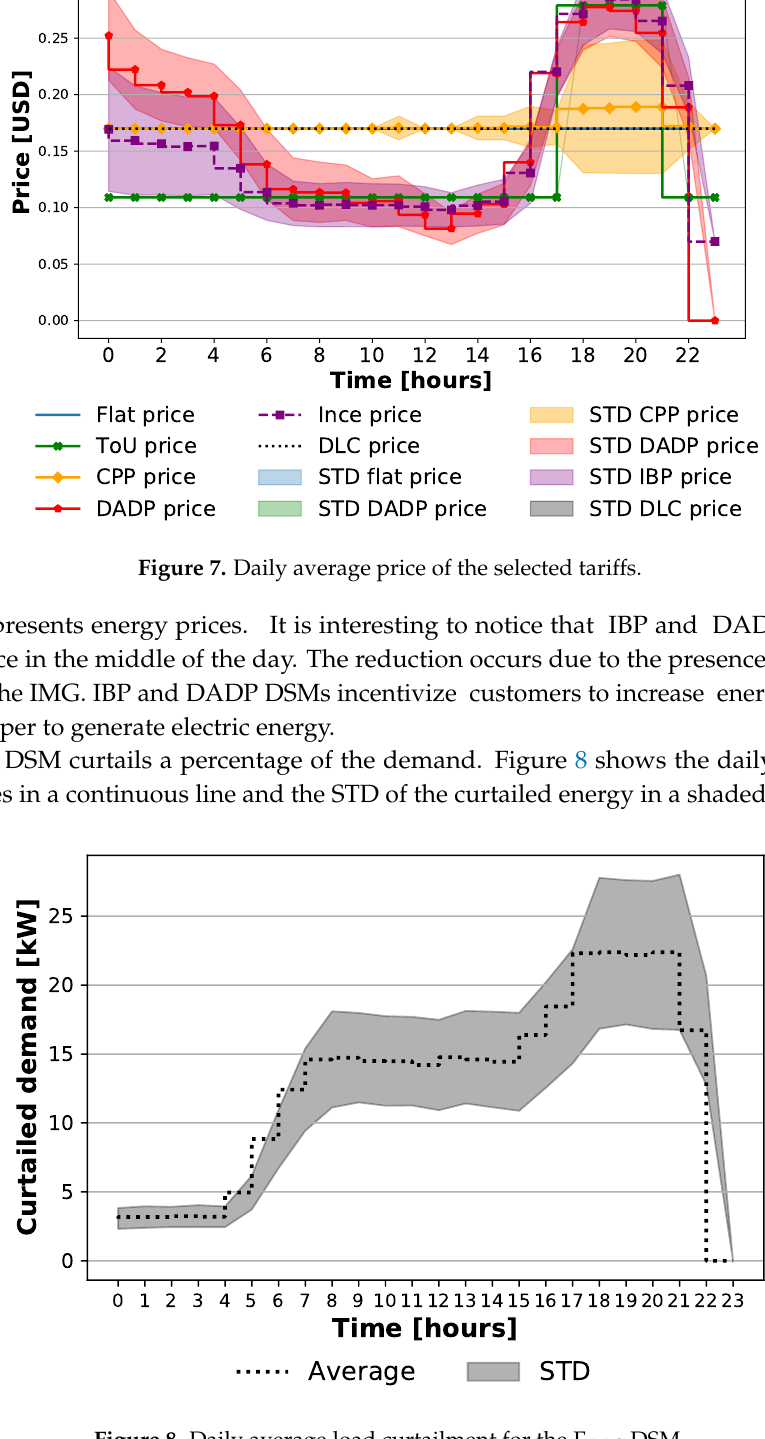
Figure 8. Daily average load curtailment for the Γ DLC DSM. The stimulus introduced by DSM strategies modifies customers’ consumption